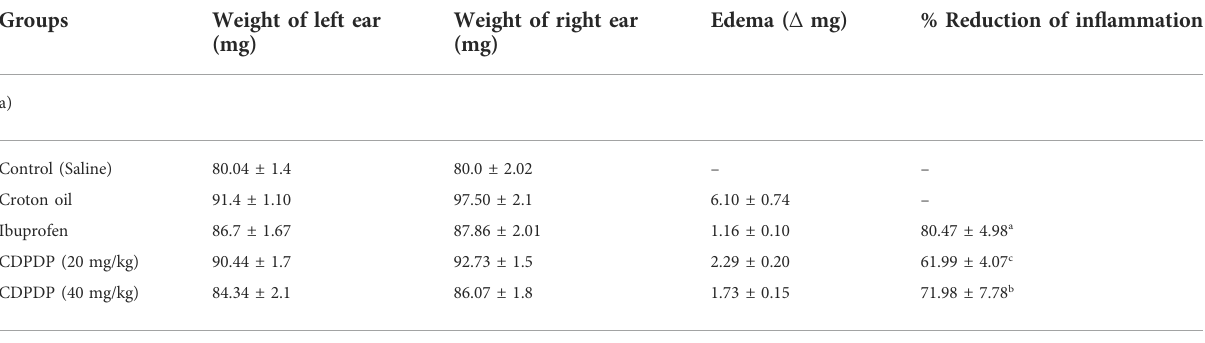
TABLE 3 Effect of CDPDP on croton oil-induced ear edema in mice.